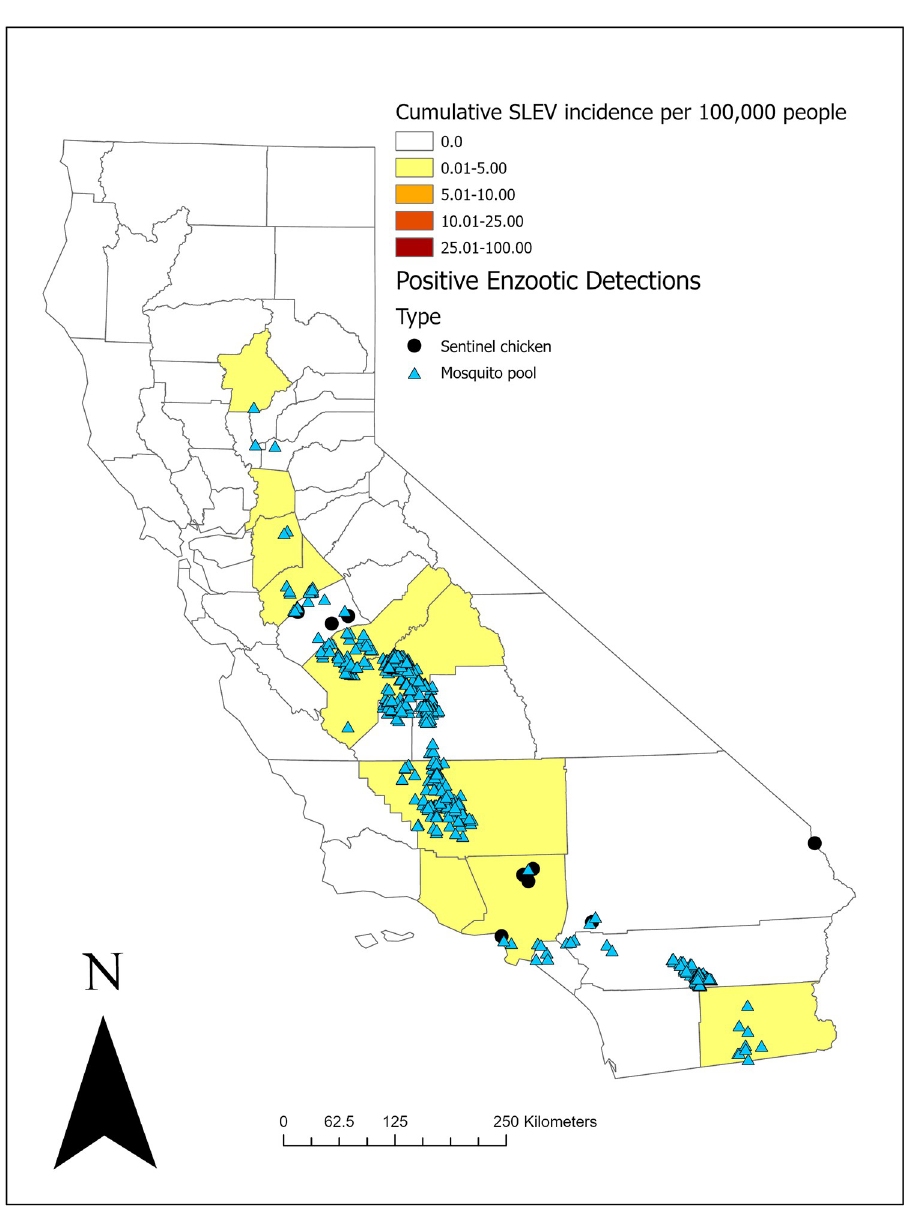
Fig 1. St. Louis encephalitis virus (SLEV) detections in California, 2015–2020. County data courtesy of U.S. Census Bureau TIGER/line spatial files, 2016. (Shapefile: https://www.census.gov/geographies/mapping-files/time-series/geo/ tiger-line-file.2016.html License information: https://www2.census.gov/geo/pdfs/maps-data/data/tiger/tgrshp2021/ TGRSHP2021_TechDoc_Ch1.pdf). SLEV infections in humans From 2015 to 2020, CDPH VRDL conducted 3,942 tests for SLEV via either MAC-ELISA, IFA, or PRNT from 1,150 individuals (S1 Table); 1,145 of the individuals were tested for both SLEV and WNV, whereas 5 were screened for only SLEV. Of these 3,942 tests, 2,974 (75%) were comparative endpoint PRNT for SLEV and WNV. There were 139 people tested via PRNT using both serum and CSF. There were 1,525 samples submitted from the 1,145